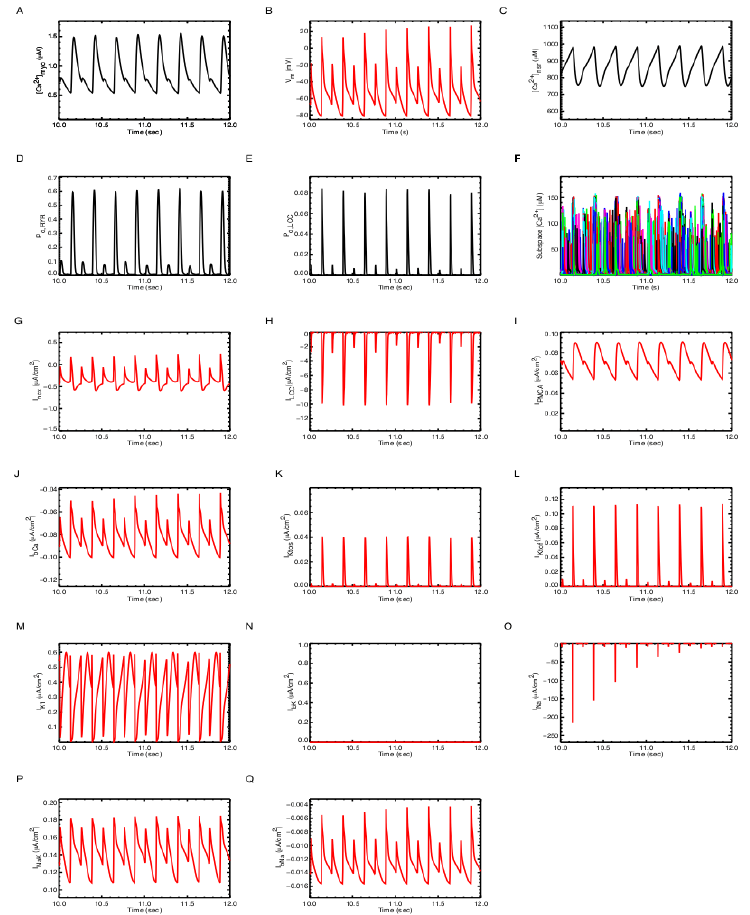
Figure A4. Pacing at 8 Hz pacing produces alternans and a diastolic [Na + ] i of 10.2 mM. To emulate the excitation-contraction of the cell, a stimulus current I stim = − 6.5189 µA/cm 2 was given during 5.0 ms second [40] . ( A ) [Ca 2+ ] myo , ( B ) Membrane potential (V m ); ( C ) Network SR Ca 2+ concentration ([Ca 2+ ] nsr ;)) ( D ) RyR2 open probability (P O ,RyR); ( E ) L-type Ca 2+ channel open probability (PO,LCC); ( F ) subspace free Ca 2+ concentration ([Ca 2+ ] ds ,) ( G ) L-type Ca 2+ current (I LCC ); ( H ) NCX current (I ncx ); ( I ) Plasmalemmal Ca 2+ -ATPase current (I PMCA ); ( J ) background Ca 2+ current (I Cab ); ( K ) slow transient outward current (I tos ); ( L ) fast transient outward current (I tof ); ( M ) K 1 current ( M ) slow component of transient-outward K + current; ( N ) Background K + current ; ( O ) Na + current; ( P ) Na + -K + ATPase current; ( Q ) Background Na + current.